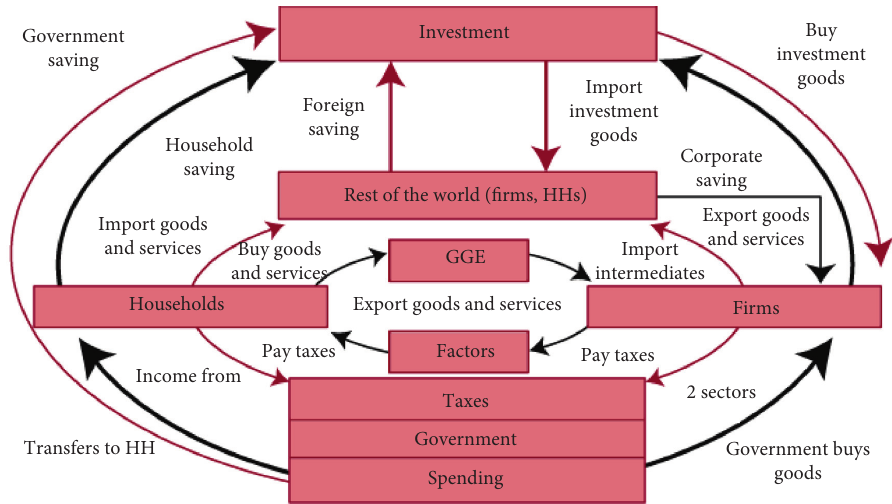
Figure 1: CGE model